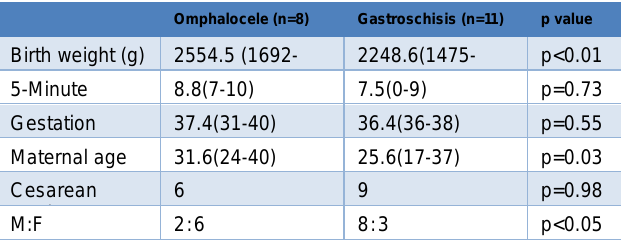
Table 1: Omphalocele and Gastroschisis (2001 – 2016)